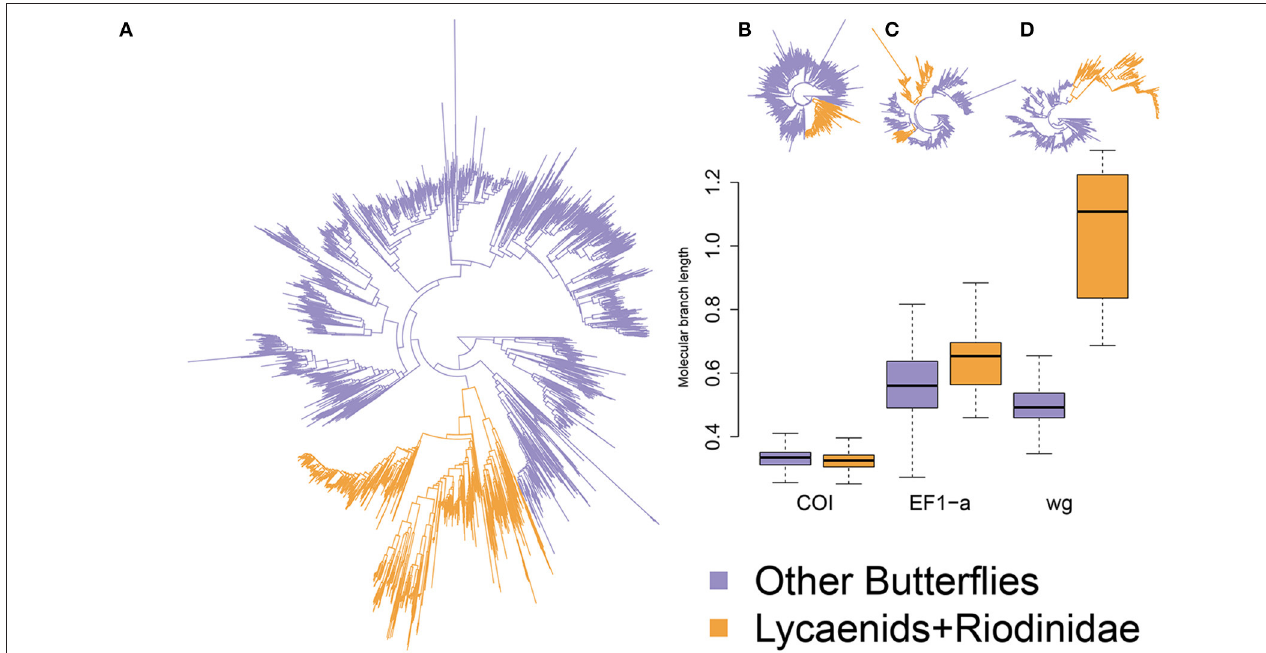
FIGURE 1 | Phylogeny of the 4891 butterfly taxa considered in this study with branch lengths proportional to substitutions per site considering all markers in (A) and each marker separately (B,C,D). Colored branches represent the myrmecophilous Lycaenidae and Riodinidae in orange and the other butterflies in blue. Boxplots show branch length for myrmecophilous and non-myrmecophilous compared with an outgroup species; centerline represents the median, hinges mark the first and third quartiles, whiskers extend to the lowest and highest